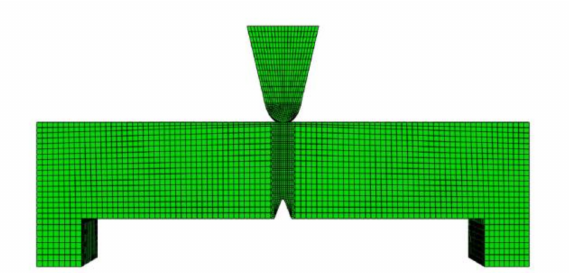
Figure 9. Mesh diagram of Charpy V − shaped impact specimen.